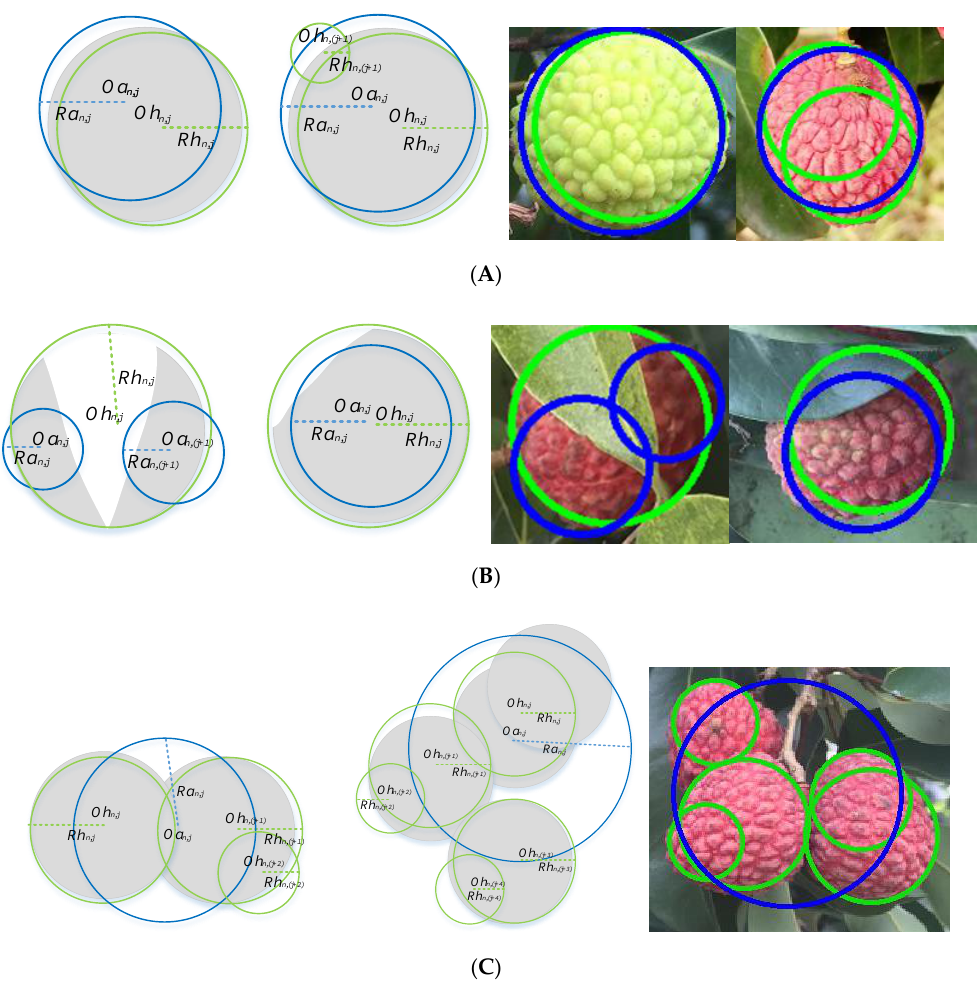
Figure 7. Topological diagrams of the lychee location relationships. ( A ) Single isolated status. ( B ) Occluded (covered with leaves and branches) status. ( C ) Overlapped status.